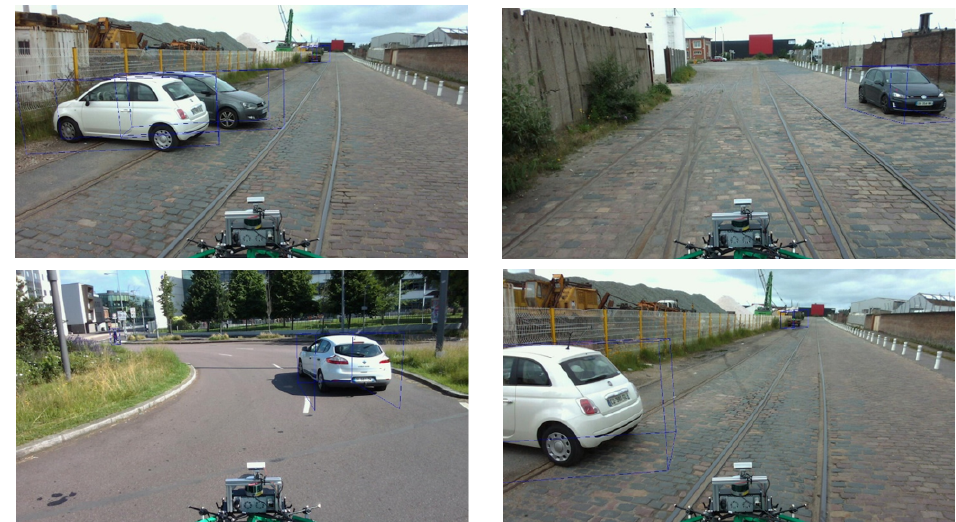
Figure 15. Examples of annotations and predictions performed on the ESRORAD real dataset. Top left : image without annotation, top right : image with annotation, bottom two images : predictions of our object detection algorithm trained on the GTAV virtual dataset.